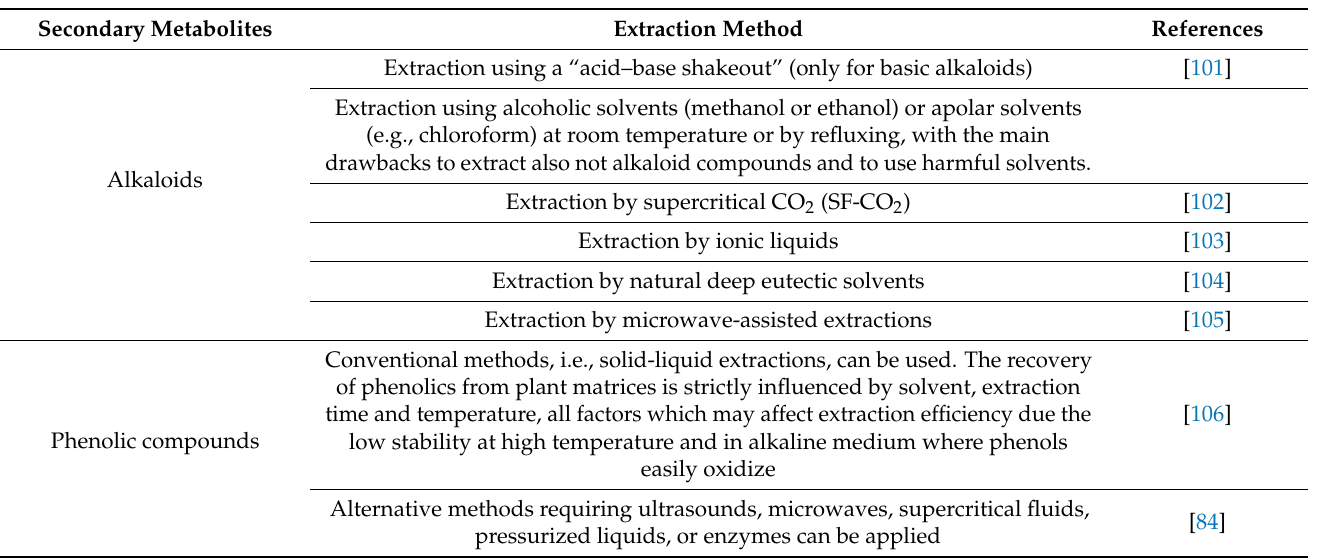
Table 1. Principal plant secondary metabolite extraction